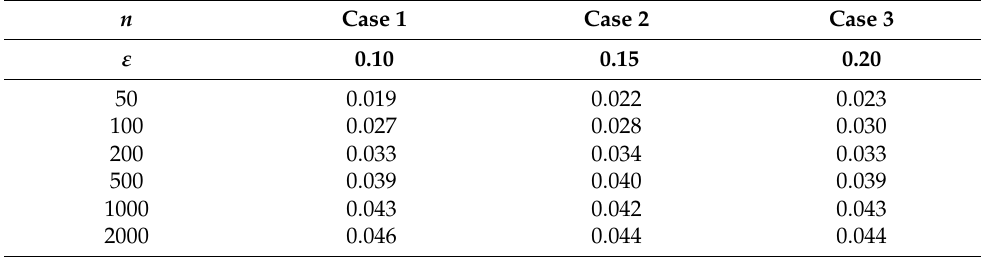
Table 5. Rejection probabilities at the nominal level α = 0.05 under the configurations in Table